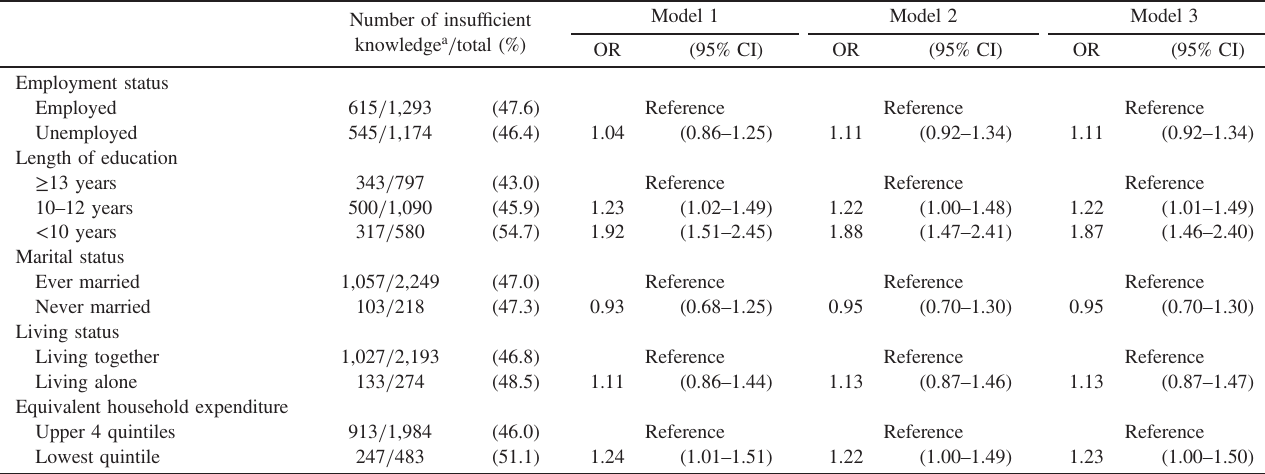
Table 3. Frequency and odds ratio for insu ffi cient knowledge on overall cardiovascular risk factors: NIPPON DATA2010